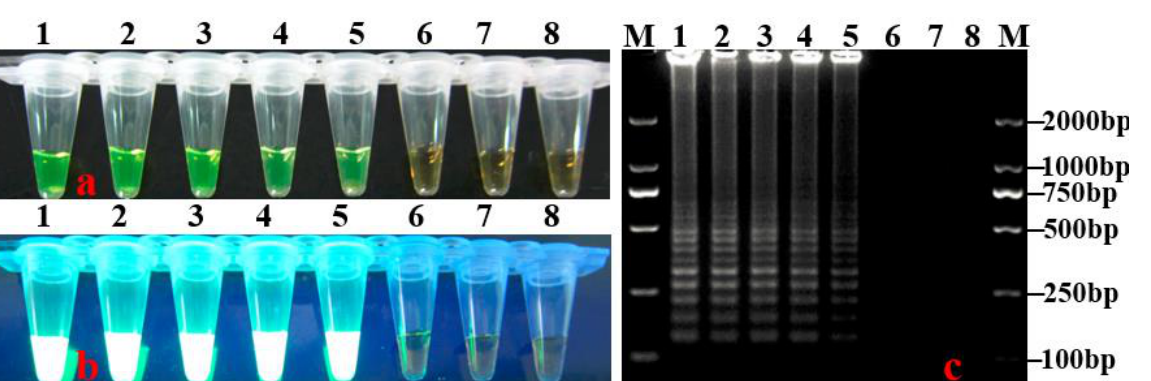
Figure 4. Specificity of LAMP. ( a ) LAMP products were visualized by naked eye under natural light (color change, yellow-green indicate positive reaction). ( b ) LAMP products were visualized by naked eye under UV light (bright white turbidity indicates positive reaction). ( c ) LAMP products were analyzed using electrophoresis on 2% agarose gel (ladder-like pattern bands indicate positive reaction). Lane 1–3: Mycocentrospora acerina ; Lane 4: Cylindrocarpon destructans ; Lane 5: Alternaria panax ; Lane 6: Colletotrichum truncatum ; Lane 7: Botrytis cinerea ; Lane 8: Negative control (SDW); Lane M: DL 2000 DNA marker. The color of tubes 1–3 is yellow-green.